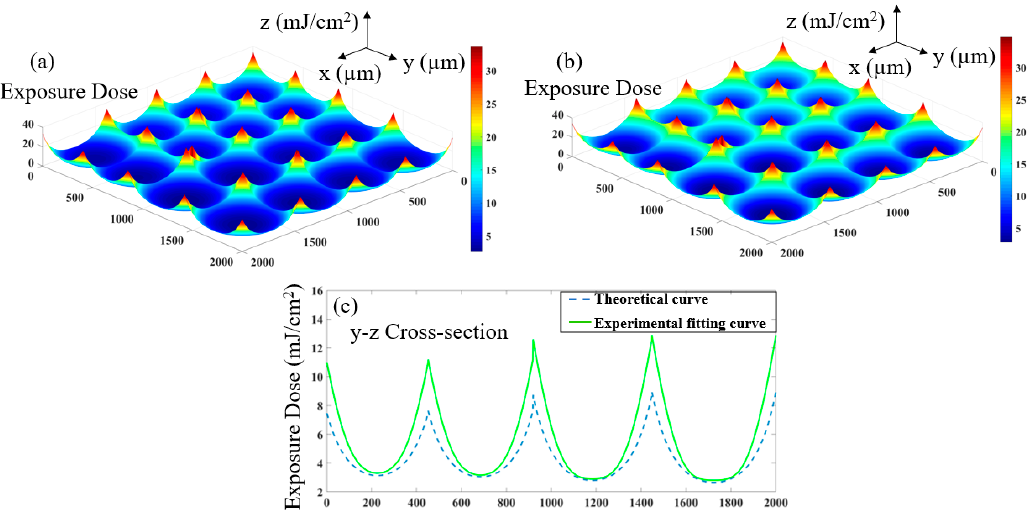
Figure 6. Comparison of degumming amount before and after correction: ( a ) Theoretical 3D distribution of degumming amount; ( b ) Corrected 3D distribution; ( c ) Section comparison before and after correction.